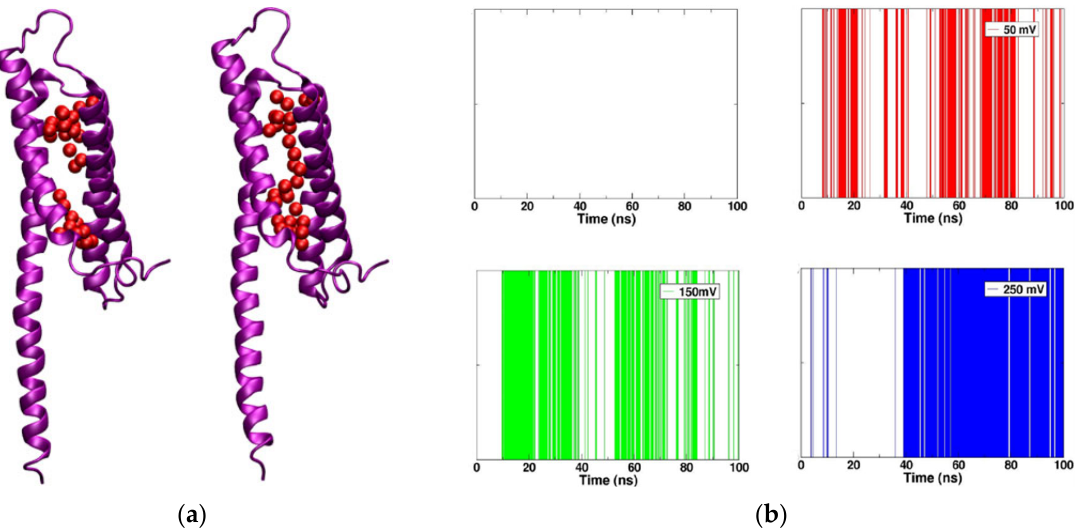
Figure 2. ( a ) Discontinuous water ‐ wire (left) and continuous water ‐ wire (right). The four transmem ‐ brane segments of mHv1cc are represented by purple ribbons; oxygen atoms of water molecules are shown as red spheres. ( b ) The water ‐ wire formation in the channel pore during the simulations. The white ‐ colored stripe, or background, represents a discontinuous water ‐ wire, and the red, green, and blue stripes represent a continuous water ‐ wire. blue stripes represent a continuous